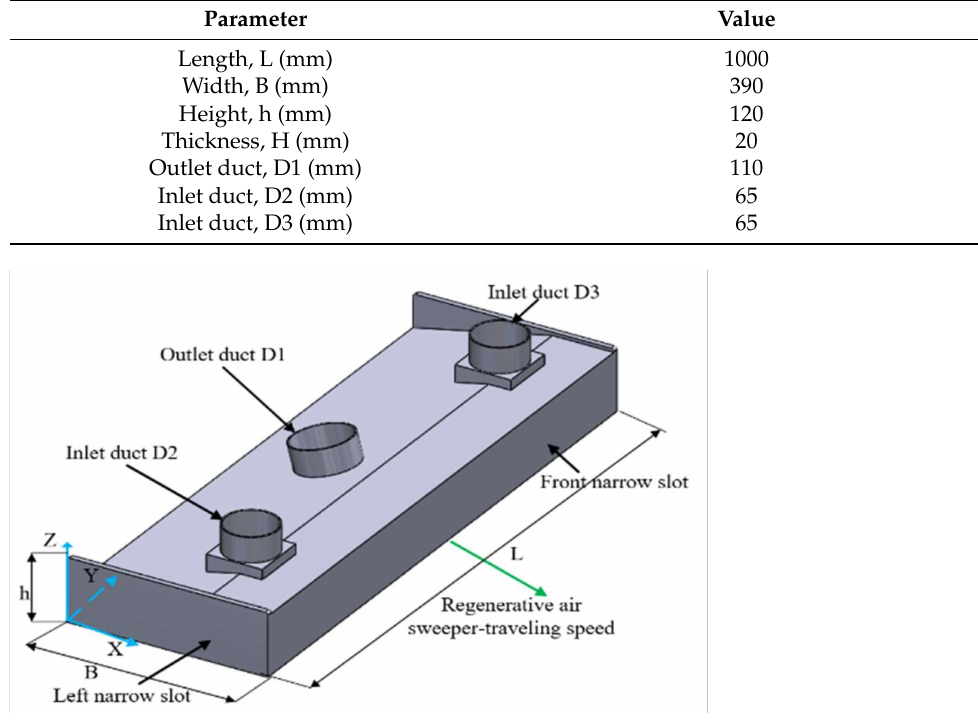
Figure 1. Physical model of the regenerative sweeper pick-up